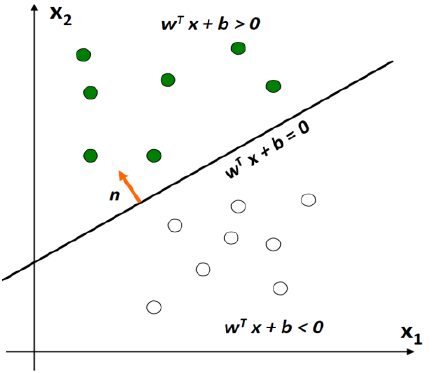
Figure 3. Two-dimensional feature space with SVM linear discrimination function.